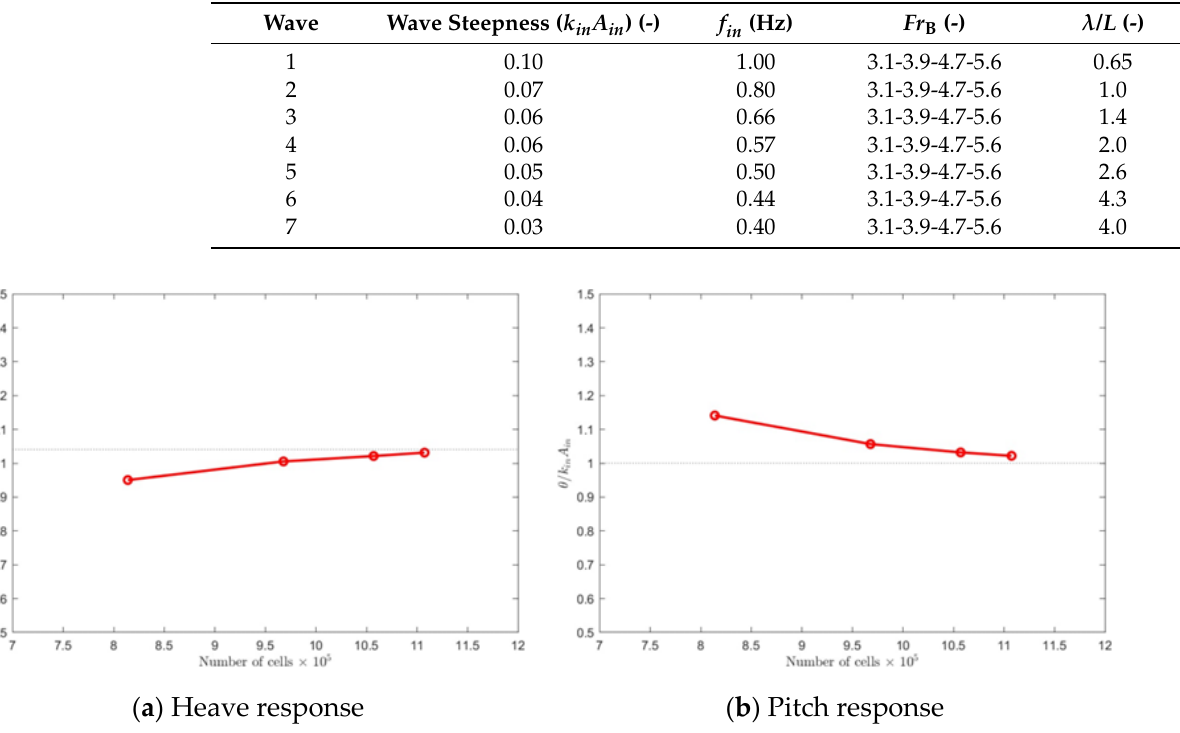
Table 4. Forcing condition of the second set of numerical experiments. Wave